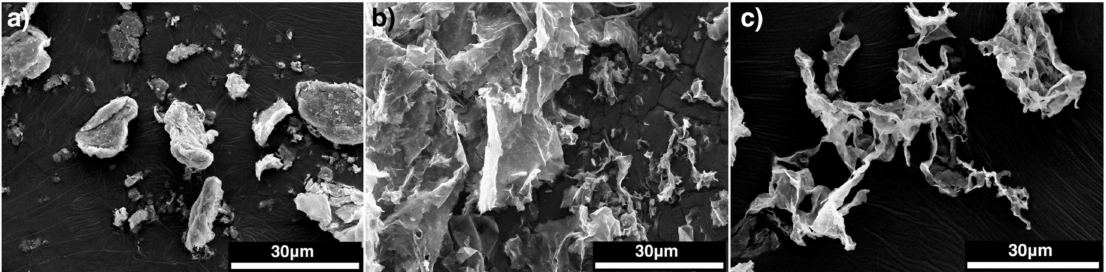
Figure 1. SEM micrographs of ( a ) SD-MMT ( b ) FD-MMT ( c )